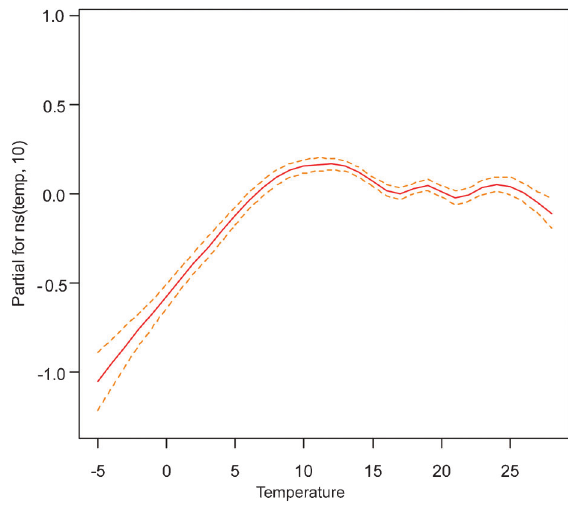
Figure 1. Air temperature effect graph (10 degrees of freedom).